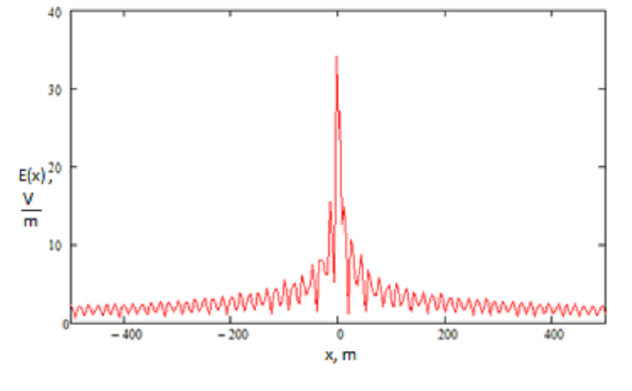
Fig. 3. Amplitude distribution of point source field for the frequency of 15 MHz